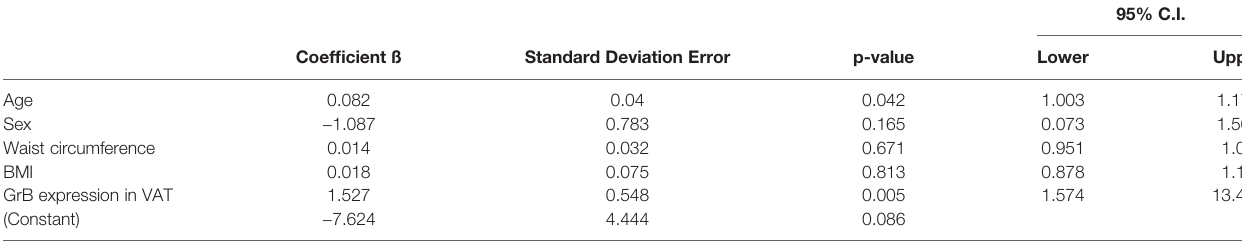
TABLE 4 | Granzyme B (GrB) mRNA expression in visceral adipose tissue (VAT) is an independent predictor of glucose metabolism alteration.